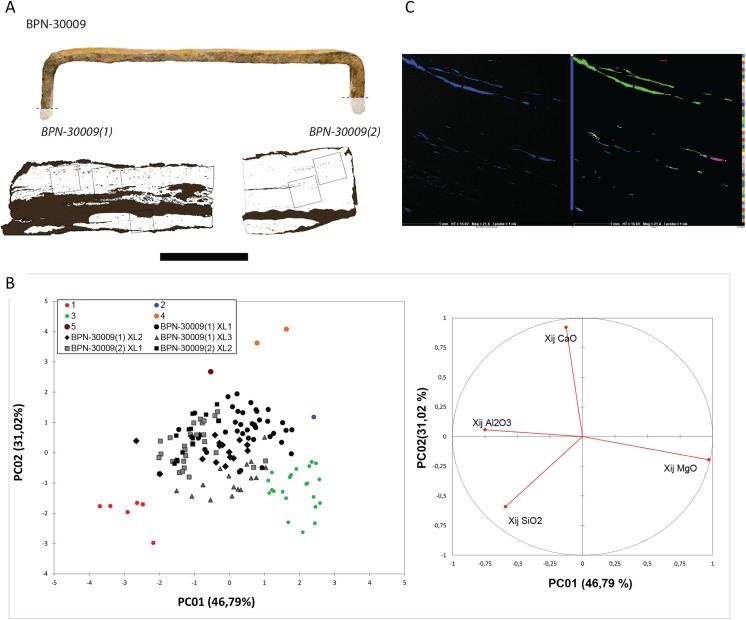
Treatment of SI measurements for BPN-30009 (BPN-30009(1) and BPN-30009(2)) for which numerous welding lines were identified.(A) Localisation of the hyperspectral maps performed on representative zones of each artefact BPN-30009(1) and BPN-30009(2). (B) (left) BPN-30009(1) and BPN-30009(2) SI subcompositional ratios (noted Xij NRC) projected onto the first two PC axes. The PCA conducted on the standardized Xij NRC (in this case, the only detectable NRCs are Al2O3, SiO2, MgO, CaO) and a hierarchical cluster analysis [21] reveals 6 groups (one color per group). Comparing group projections and loading structure (right), “black and grey” group is identified as smelting slag; red group seems to be derived from or contaminated with silica flux; green, blue, brown and orange groups derived from or contaminated with fuel ash. For more information [21]. (C) (left) X-ray map of an analyzed zone at O Kαline and spotting of the contaminated SI identify by the statistical analysis. (Right) The SI colored in green are representing SI from green group. It is not possible to identify various groups within the group identified as smelting slag evidencing that the Xij NRC and therefore the chemical signatures are comparable for the different parts of BPN-30009(1) and BPN-30009(2) and between them. No case of recycling was detected for BPN-30009.